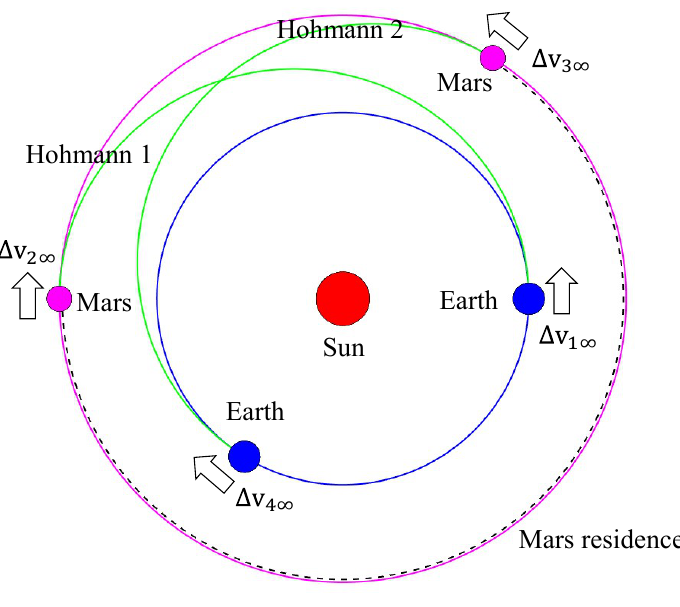
Figure 2. Mission profile for impulse maneuver transfers (Hohmann transfers) in heliocentric coordi- nate system.